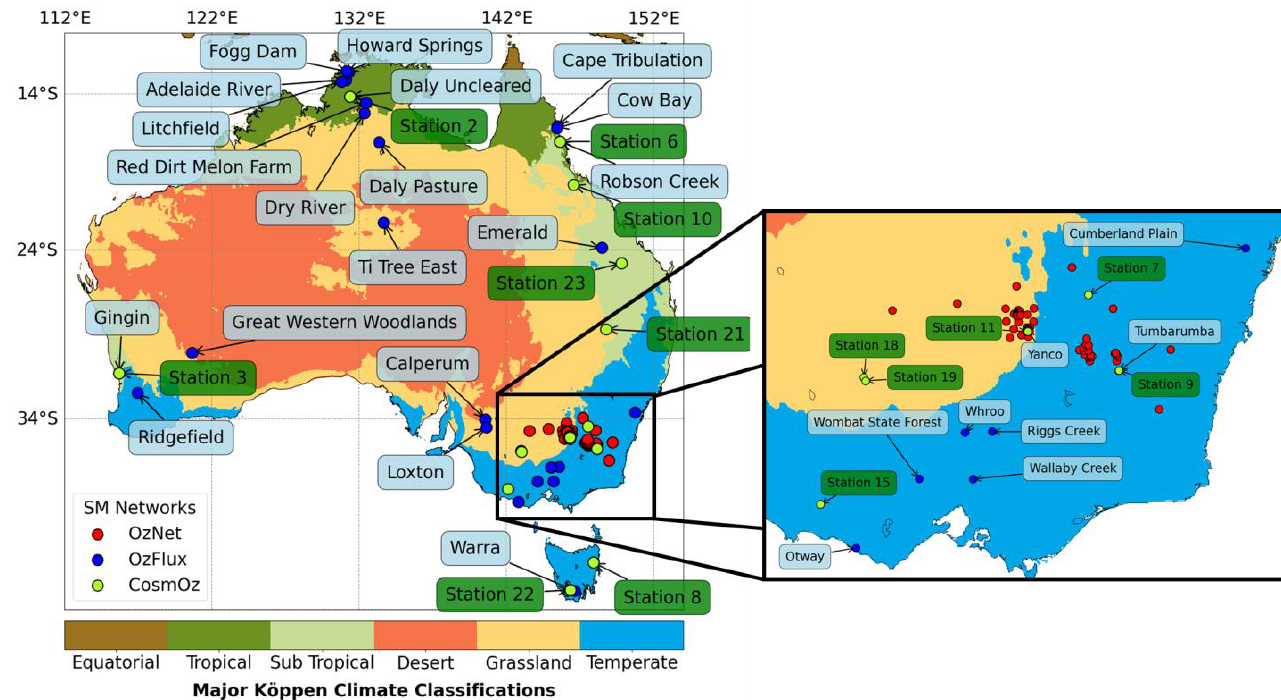
Figure 1. In situ SM station networks and their distribution over different Australian Köppen climate zones (Climate Zone data sourced from BoM [39]).